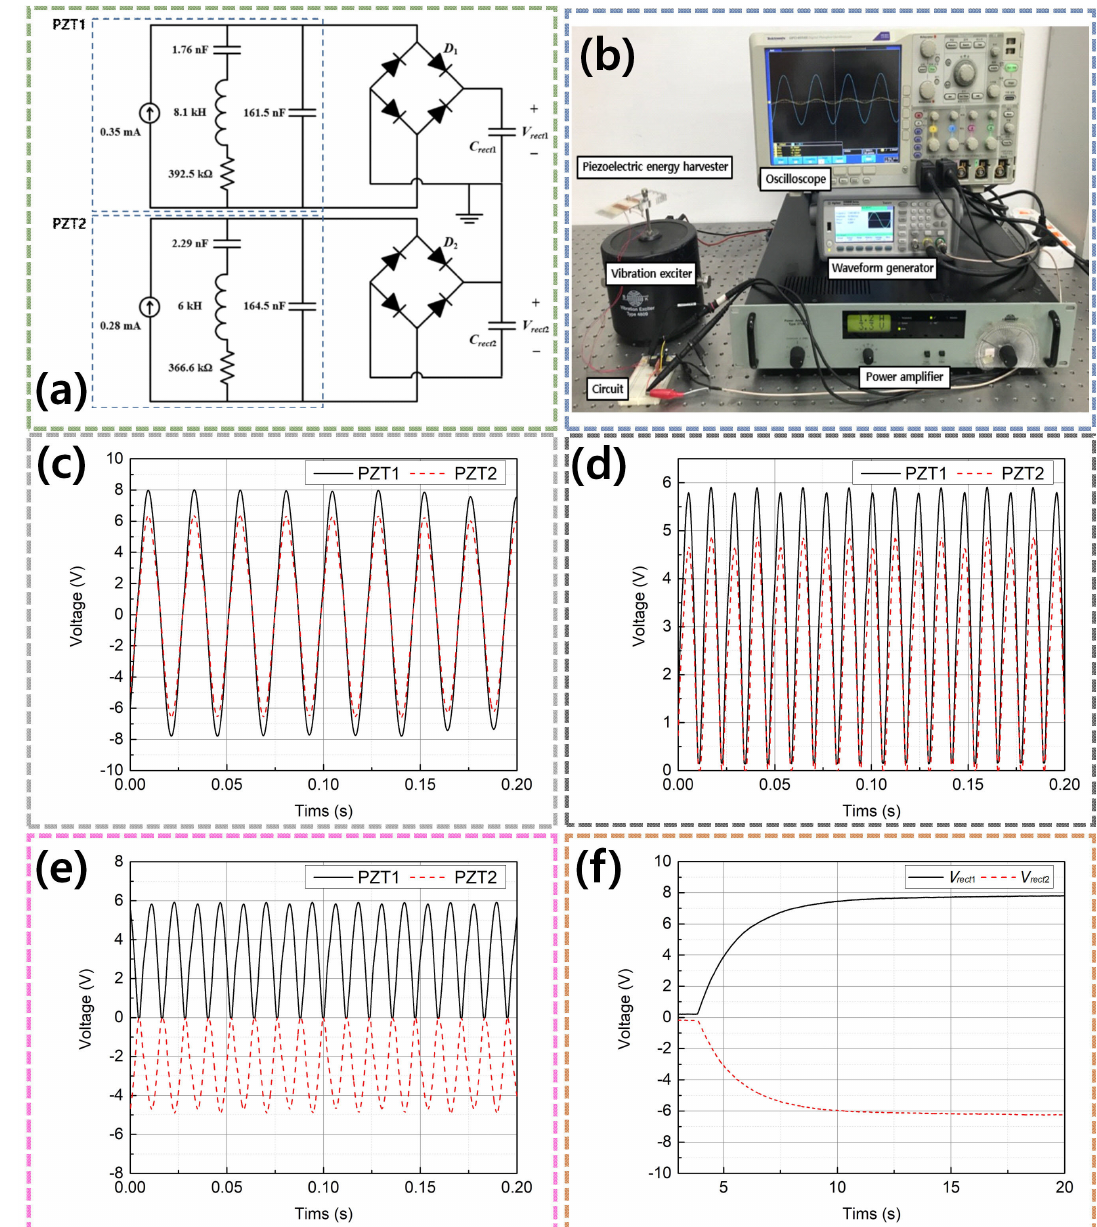
Figure 6. ( a ) Schematic of the standard interface circuit. ( b ) Experimental setup for testing the standard interface circuit. Waveforms of the PEH ( c ) Output voltages of PZT1 and PZT2. ( d ) Rectified voltages. ( e ) Bipolar voltages. ( f ) Charged voltages in the